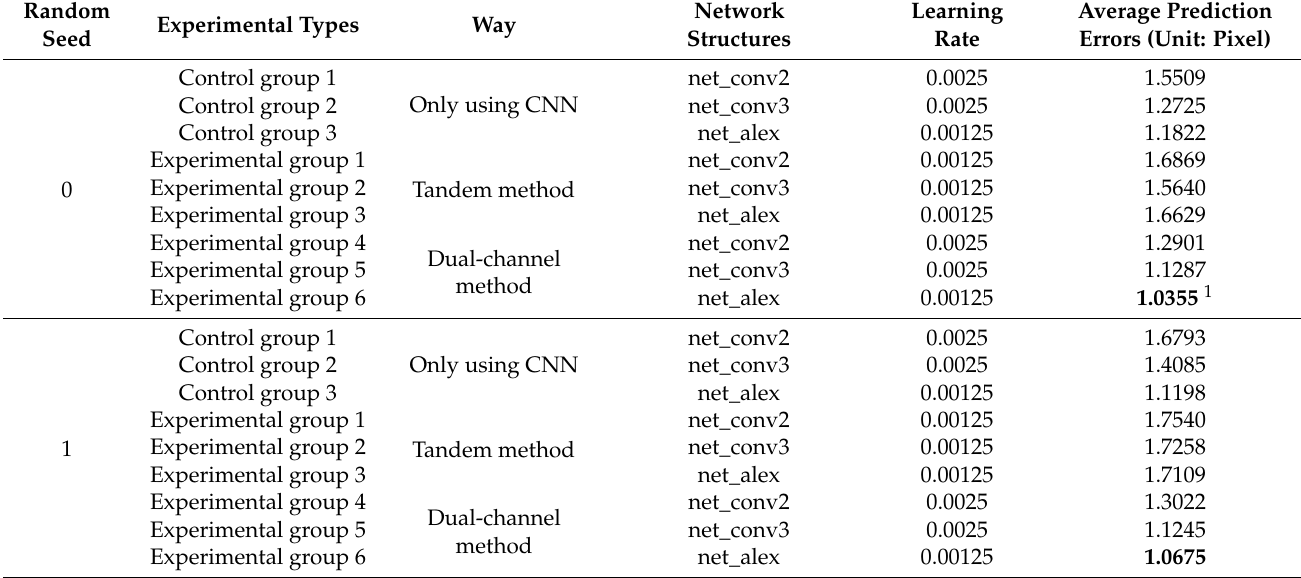
Table 3. Total average prediction errors of five parameters in experiments.